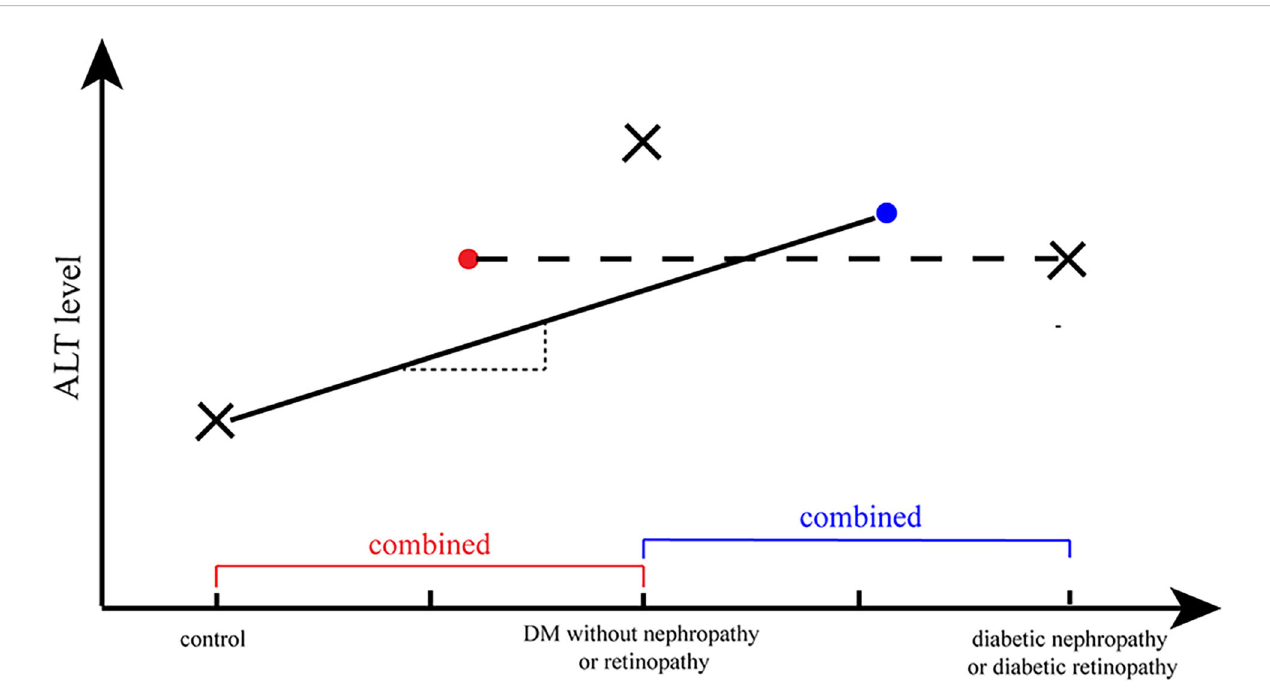
FIGURE 5 A illustrative diagram to interpret the null causal relation of ALT and diabetic nephropathy/diabetic retinopathy. The cross marks (×) represented the ALT level in different phases of diabetes and the dots (·) represented the average ALT level of a combination group (e.g., the cross mark in the right represented the average level of ALT in individuals with diabetic nephropathy/retinopathy; and the blue dot represented the average level of ALT in DM without diabetic nephropathy/retinopathy group and diabetic nephropathy/retinopathy group). The straight line with a positive slope (representing a positive correlation between the two traits) represented the possible fi tted MR analysis of ALT and DM, and the horizontal line (corresponding to no correlation between two attributes) represented the possible fi tted MR analysis of ALT and diabetic